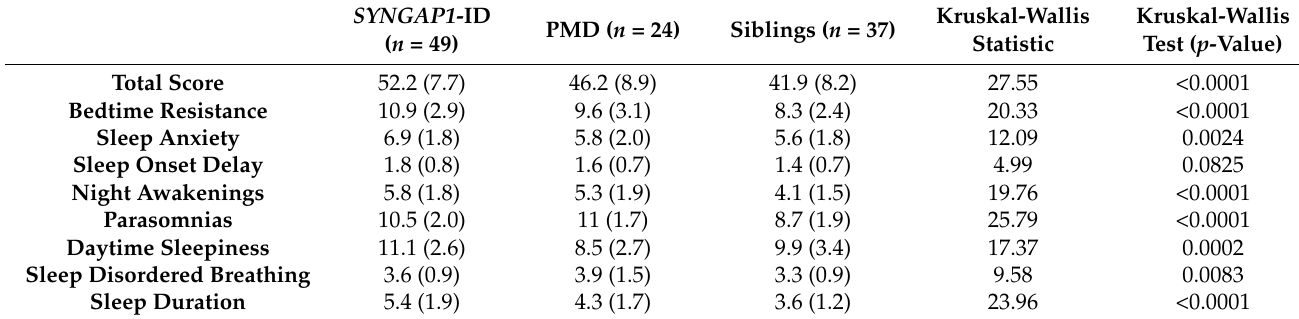
Table 3. CSHQ data under 11 years old, mean (standard deviation).